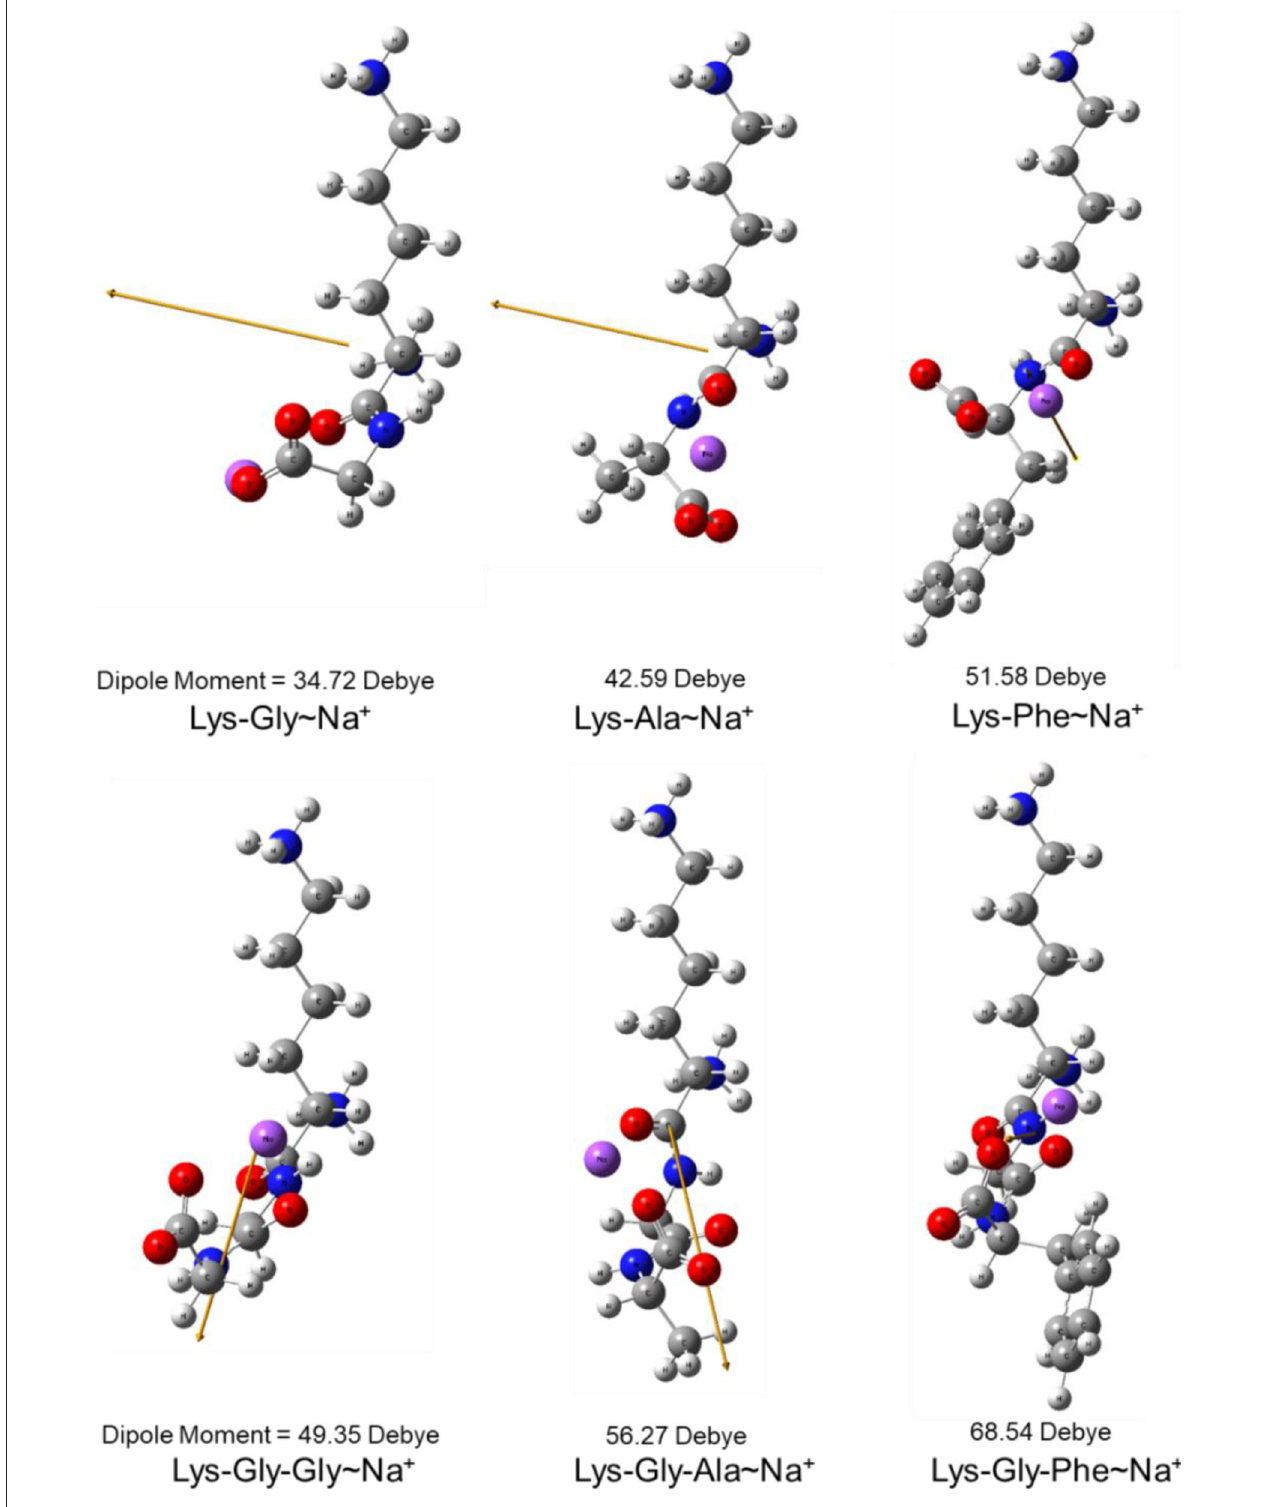
FIGURE 3 | Steric structure of proposed peptide-sodium complexes and their dipole moments (the yellow arrow represents the dipole derivative unit vector and the Na + ion is highlighted in purple).